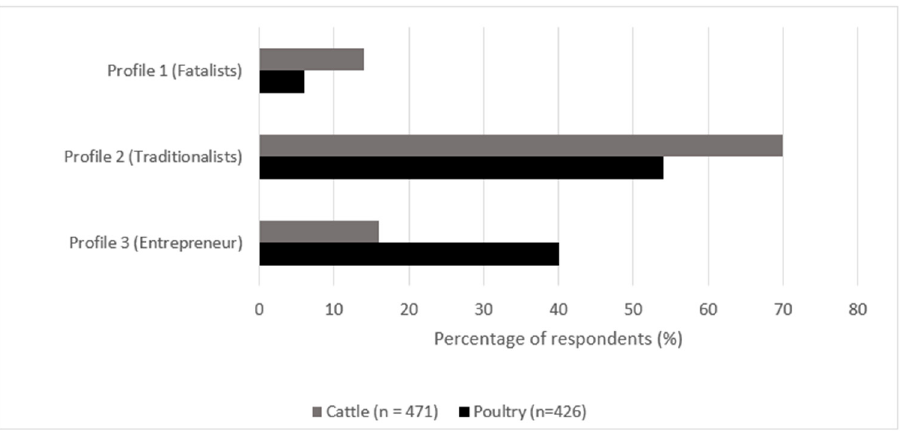
Figure 4. Distribution of smallholder cattle and poultry farmers based on their psychological attrib- utes.